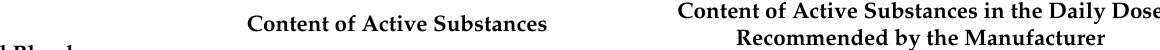
Table 2. Content of polyphenols (TPC) and flavonoids (TFC) and their daily dose in the tested extracts from herbal tea blends.